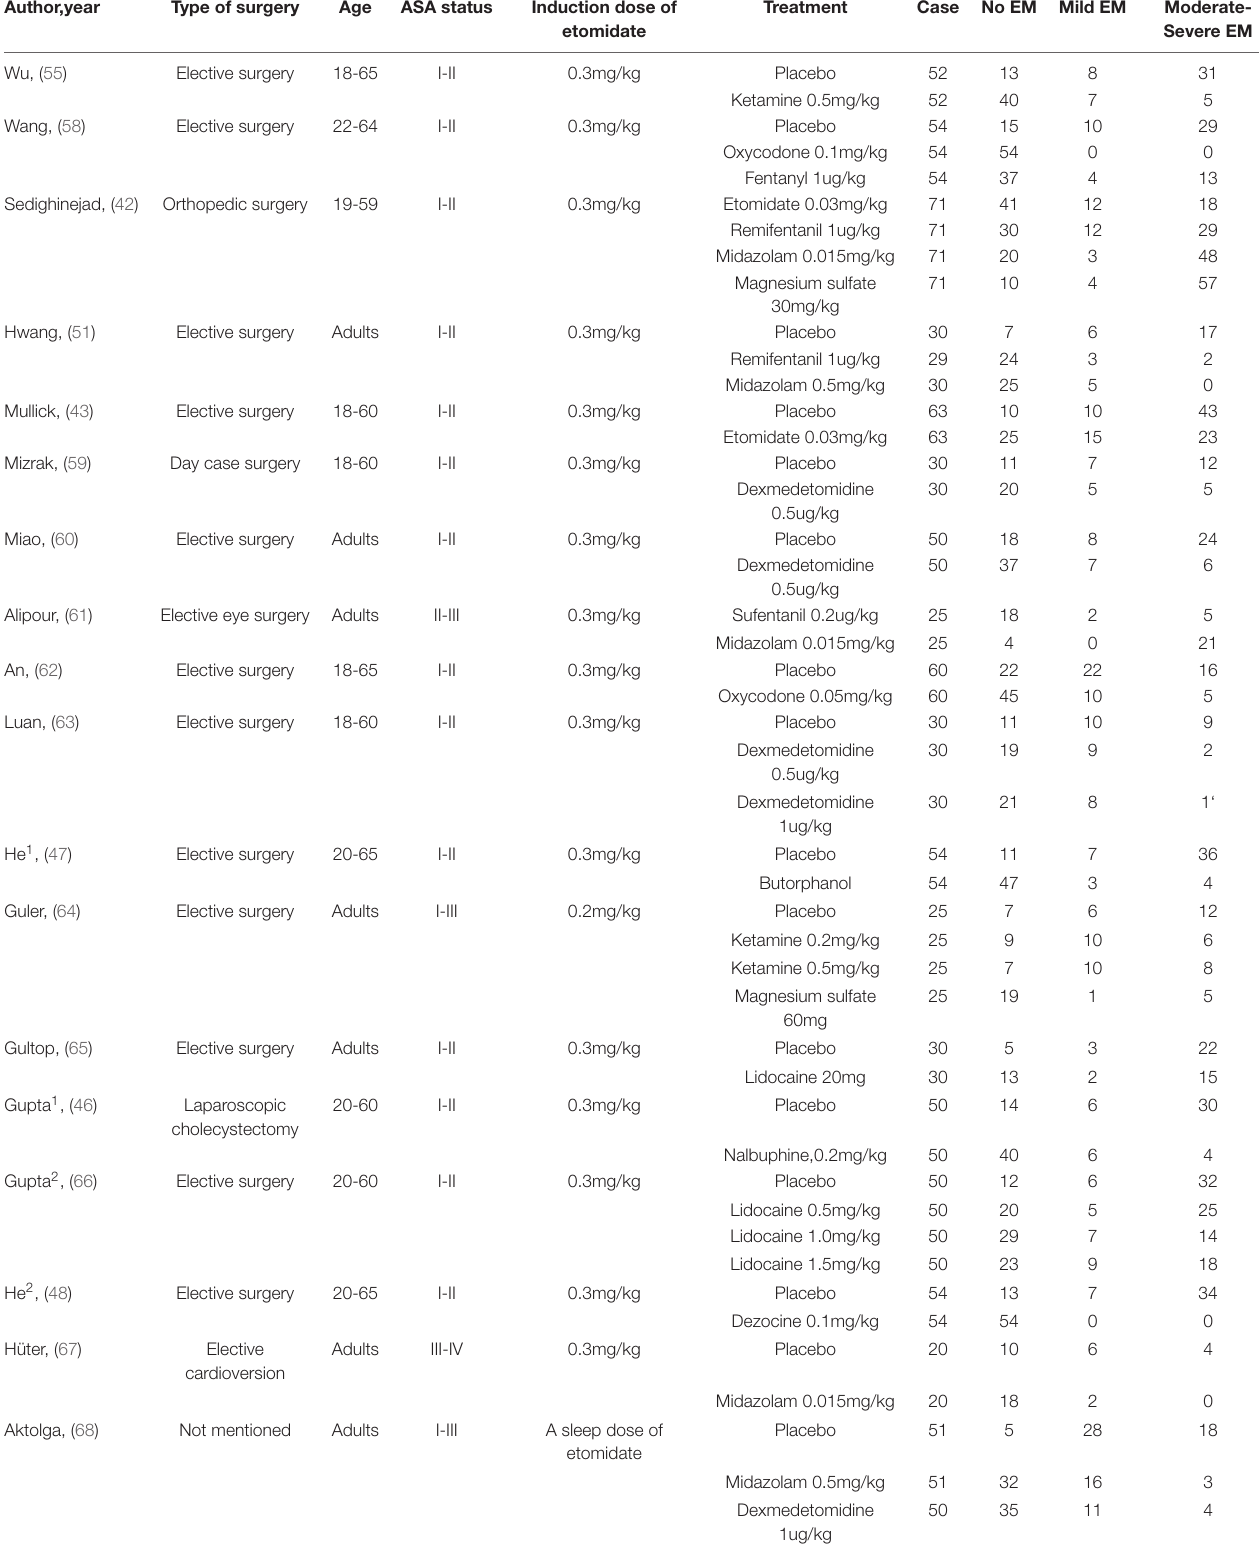
TABLE 1 | Characteristics of included